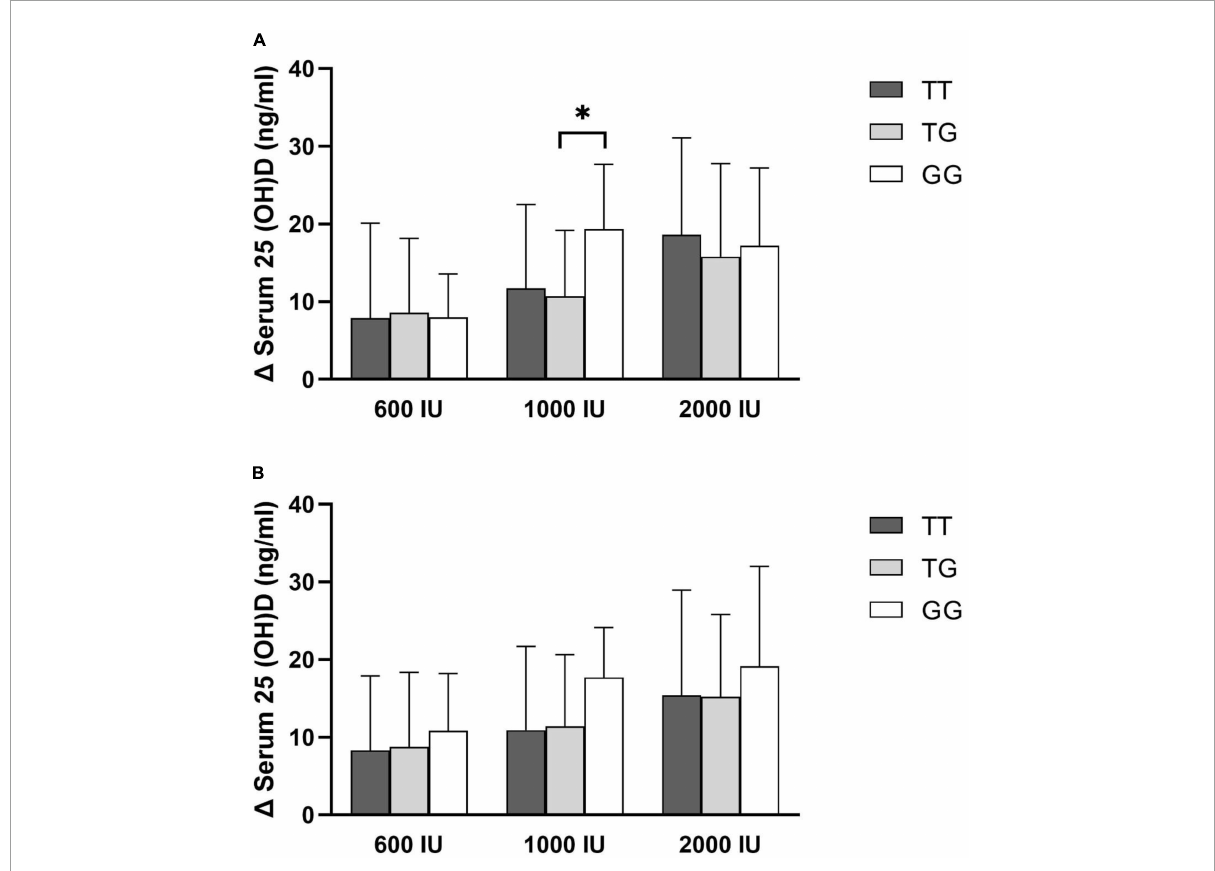
FIGURE1 Changes in serum 25(OH)D concentration by rs2282679 polymorphism in each treatment group. (A) 6-month change, (B) 12-month change.